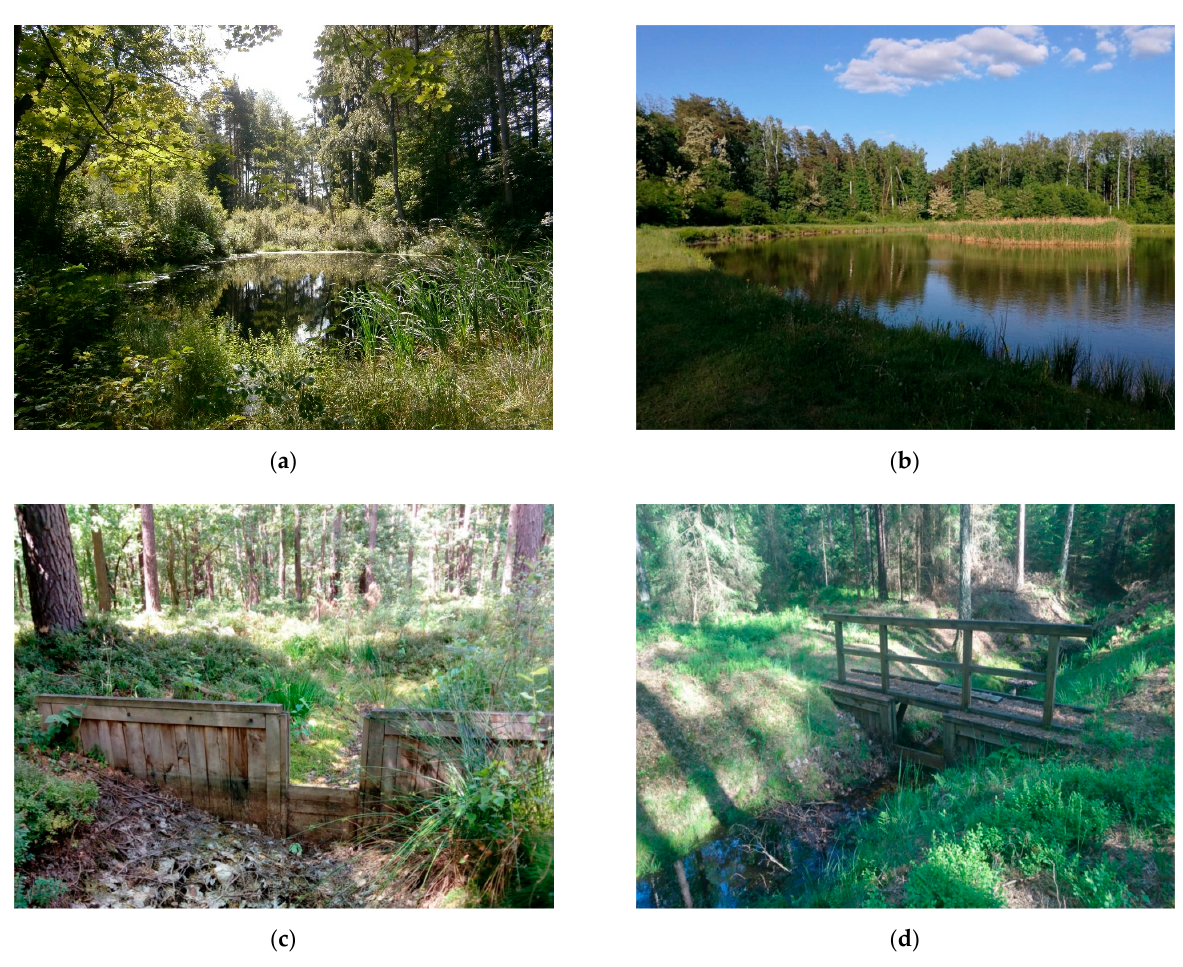
Figure 2 . Retention reservoir in the Maskuli ń skie ( a ) and Soko ł ów ( b ) forest districts, dams damming water in Figure 2. Retention reservoir in the Maskuli´nskie ( a ) and Sokoł ó w ( b ) forest districts, dams damming water in the the Celestynów ( c ) and Bi ł goraj ( d ) forest districts [19,47–49]. Celestyn ó w ( c ) and Biłgoraj ( d ) forest districts